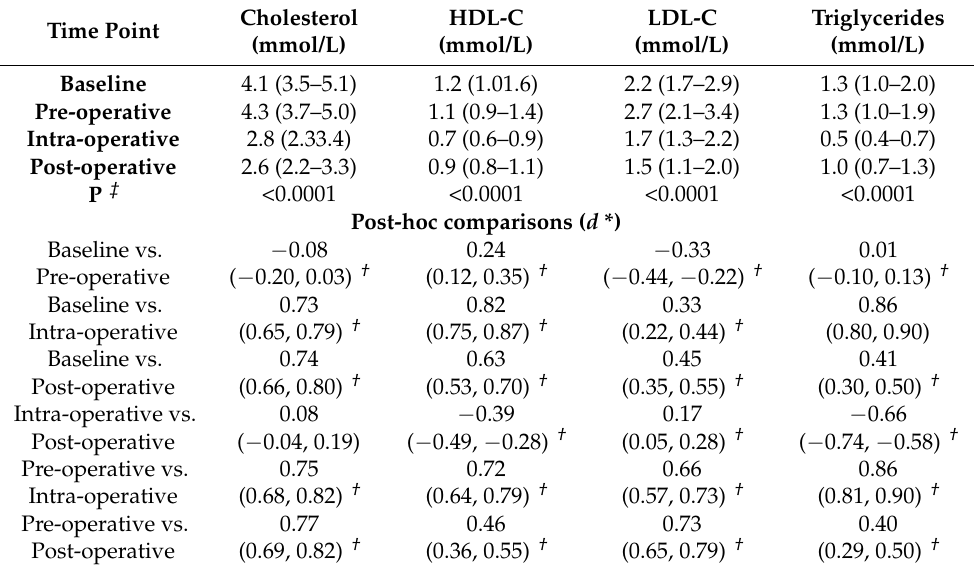
Table 2. Descriptive statistics of cholesterol, HDL-C, LDL-C, and triglycerides at the different time points. Means and interquartile ranges are shown, and p -values indicate if the lipid values differ at the four time points. Post-hoc comparisons of pairwise differences in lipid levels are illustrated with Cliff’s delta ( d ) as effect